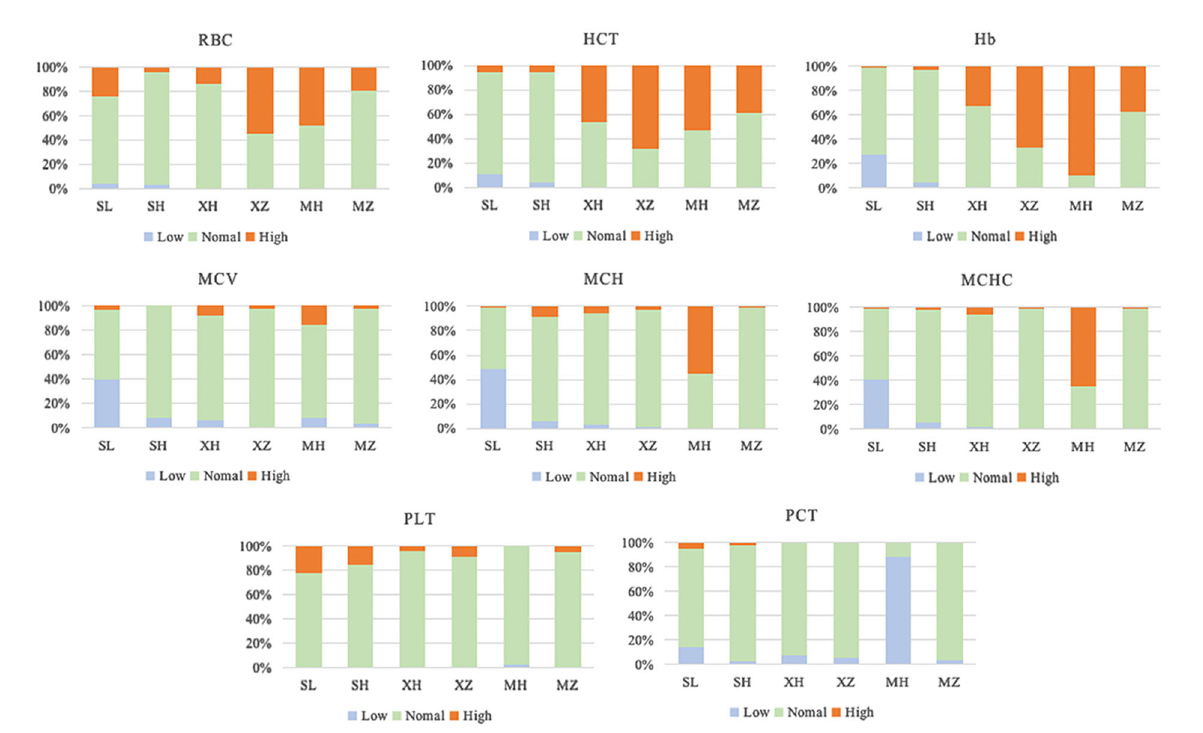
FIGURE2 RBT abnormal rate of the enrolled population. SL, the Sanya Li nationality; SH, the Sanya Han nationality; XH, the Xining Han nationality; XZ, the Xining Tibetan nationality; MH, the Maduo Han nationality; MZ, and the Maduo Tibetan nationality. RBC, Red blood cell count; HCT, hematocrit; HB, hemoglobin content; MCV, mean red blood cell volume; MCH, mean red blood cell hemoglobin; MCHC, mean red blood cell hemoglobin concentration; PLT, platelet count; PCT, platelet specific